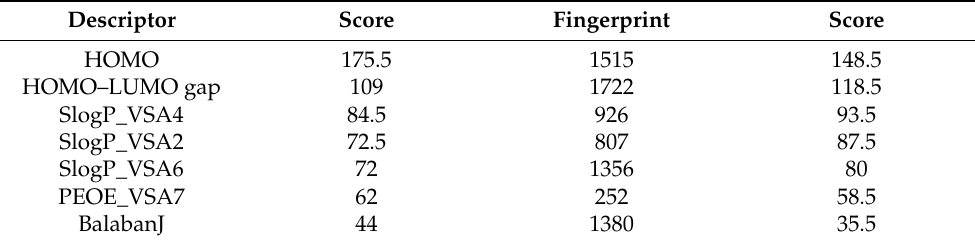
Table 2. Feature importance points of features with a large contribution for prediction.